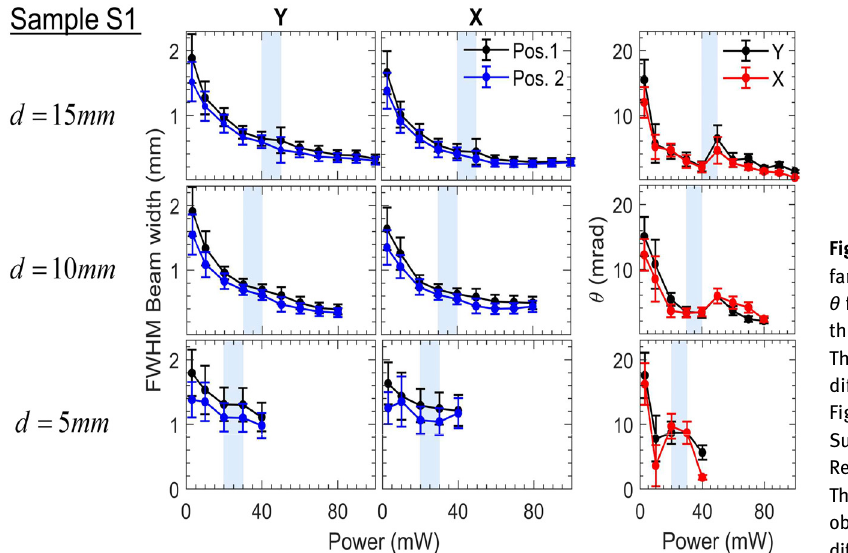
Figure 2: Experimental measurements of the far-field FWHM beam width and divergence θ for sample S1 as a function of power for threedifferentvaluesof d (15,10and5mm). The beam width was determined at two different positions in the far fi eld (shown in Figure 1(a) and in Figure A1(a) of the Supplementary material) to evaluate θ . Results over both Y and X axis are